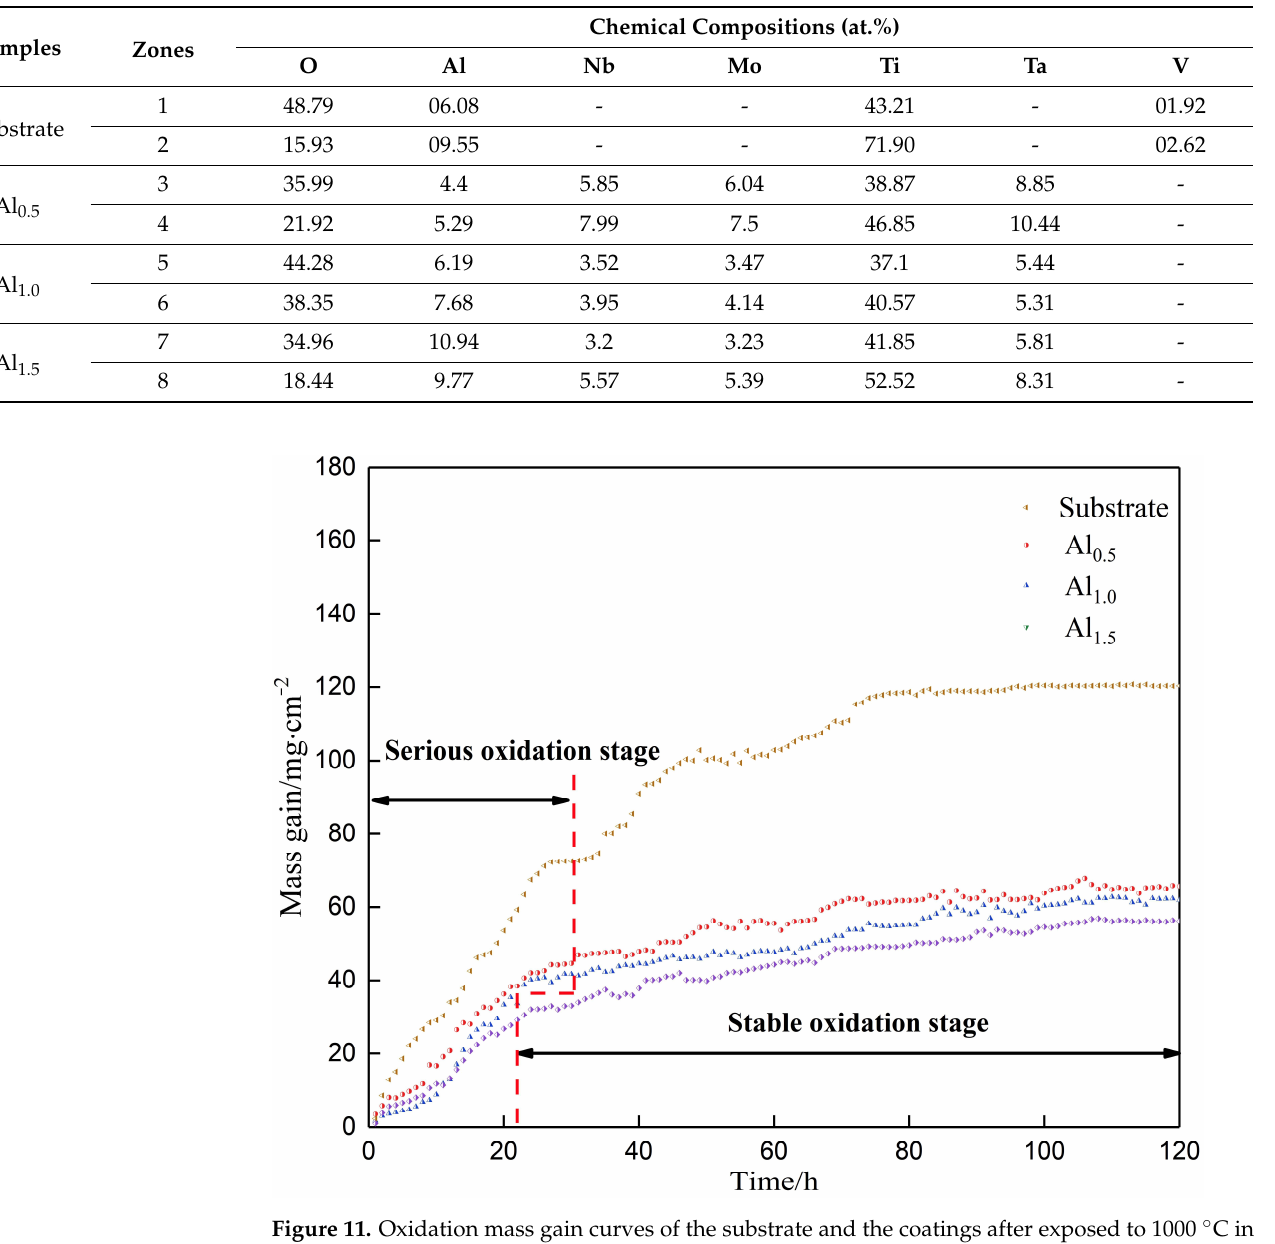
Table 2. Chemical compositions (precision of 1–5%) of the zones on the worn surfaces of the substrate and the coatings marked in Figure 10.